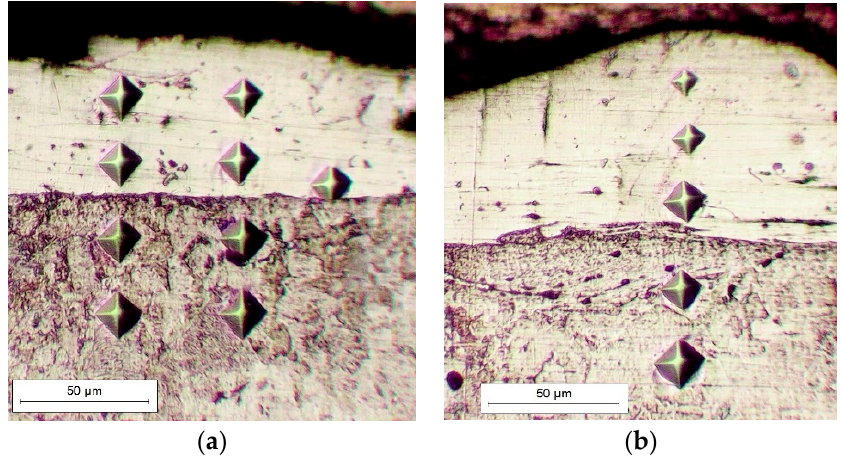
Figure 9. Micrographs of St.45 steel samples with 3-component TiAlN ( a ) and TiSiC ( b ) coatings. 3.2. Evaluation of the Tribological Characteristics of Coatings on Steel C45 Obtained by ESA with TiAlC, TiAlN, and TiSiC Compositions